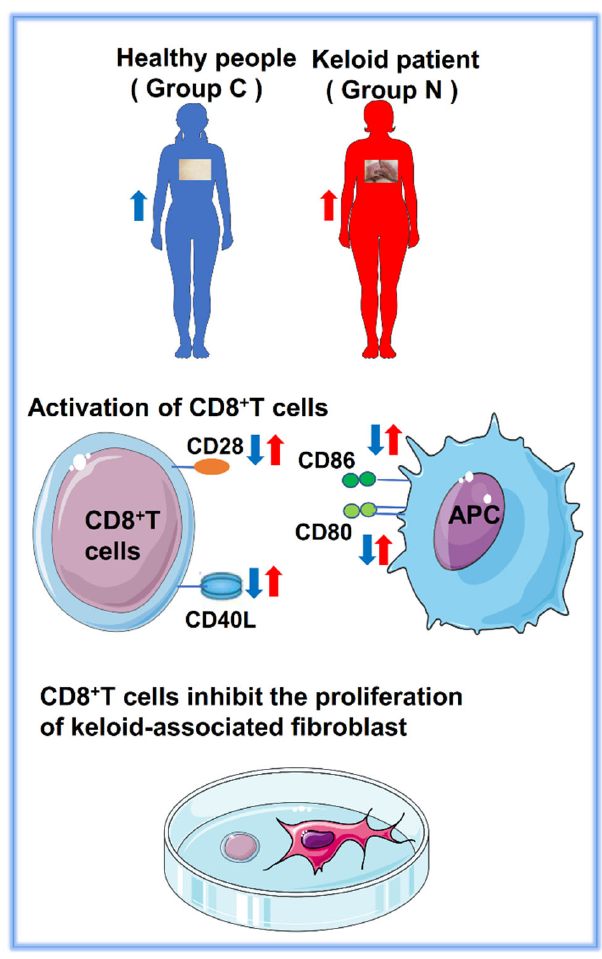
Figure 11. Landscape of this study. The blue arrow represents the expression level of markers in healthy people of Group C. The red arrow represents the expression level of markers in keloid patients of Group N. Arrow up means high expression and arrow down means low expression.